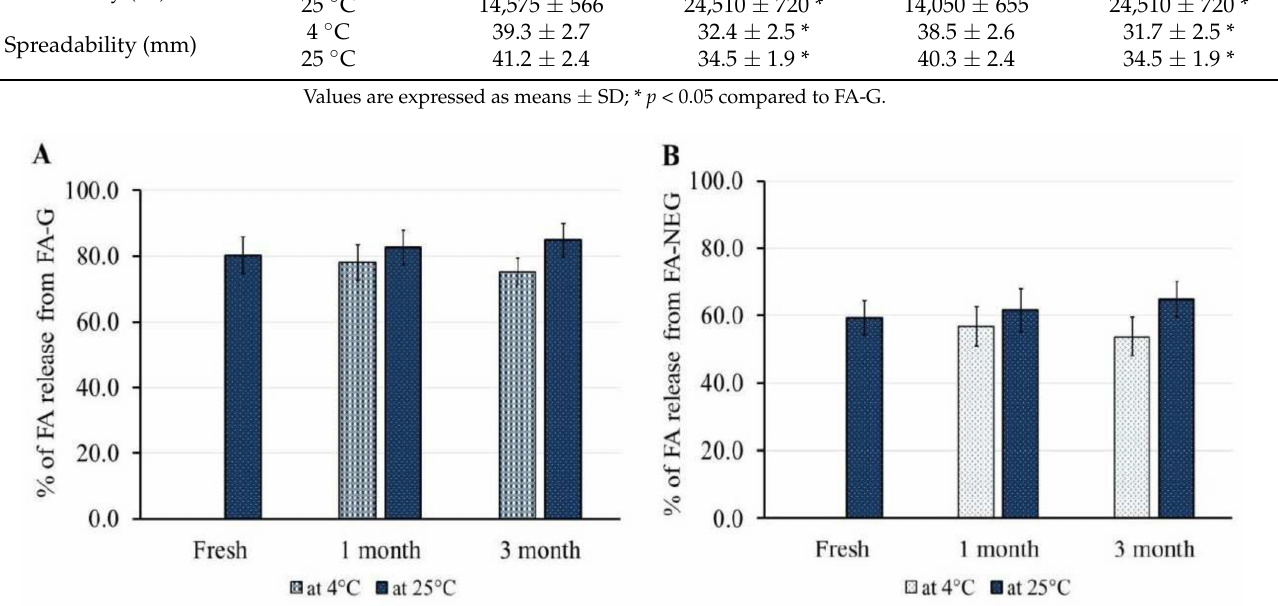
Figure 11. Outline of stability studies for ( A ) FA-G and ( B ) FA-NEG formulations for 1 and 3 months at 4 ◦ C and 25 ◦ C in terms of in vitro drug release, compared to their corresponding freshly prepared formulations. Data are expressed as means ± SD for three